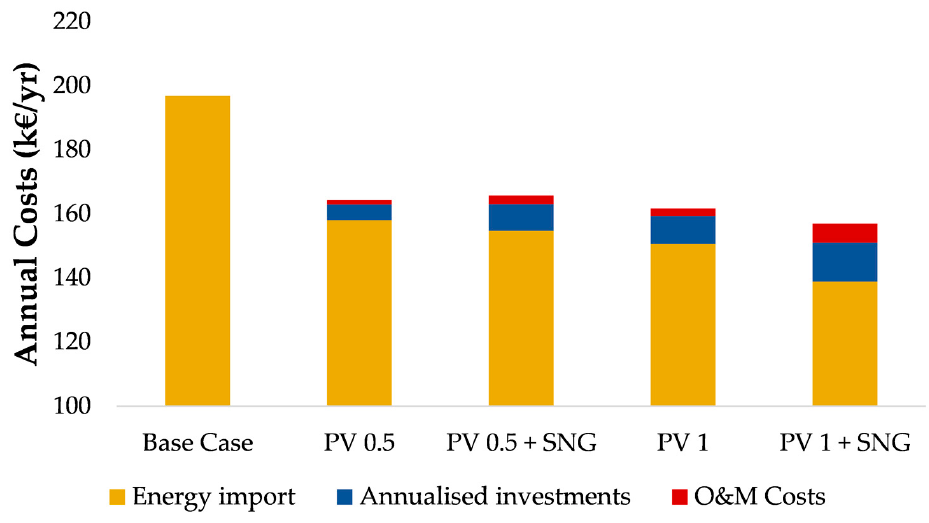
Figure 10. Annual costs of the energy district in the five scenarios.